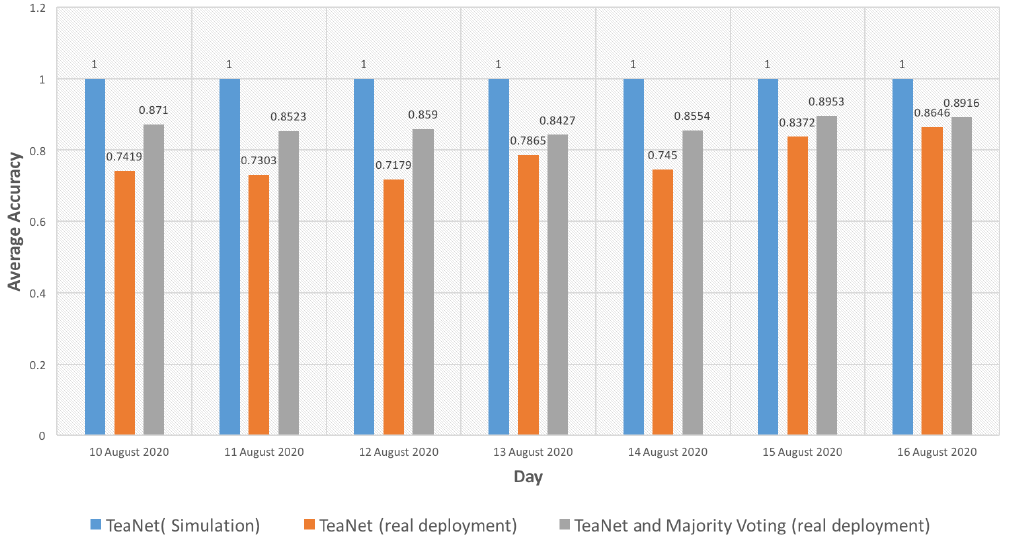
Figure 10. The average accuracy of the TeaNet system in monitoring optimum tea